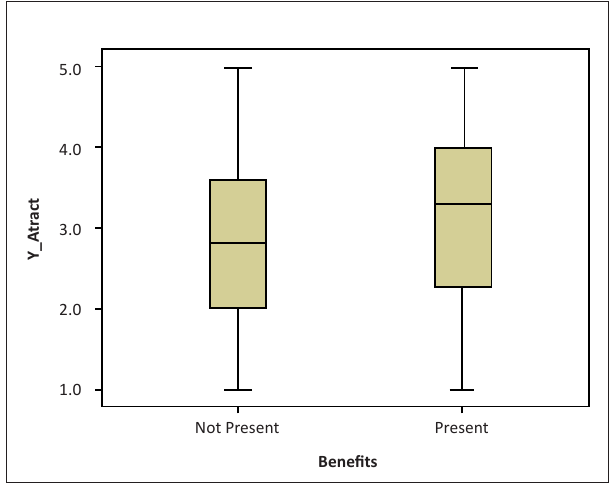
FIGURE 5: Box plot of a reward package consisting of remuneration and variable pay.